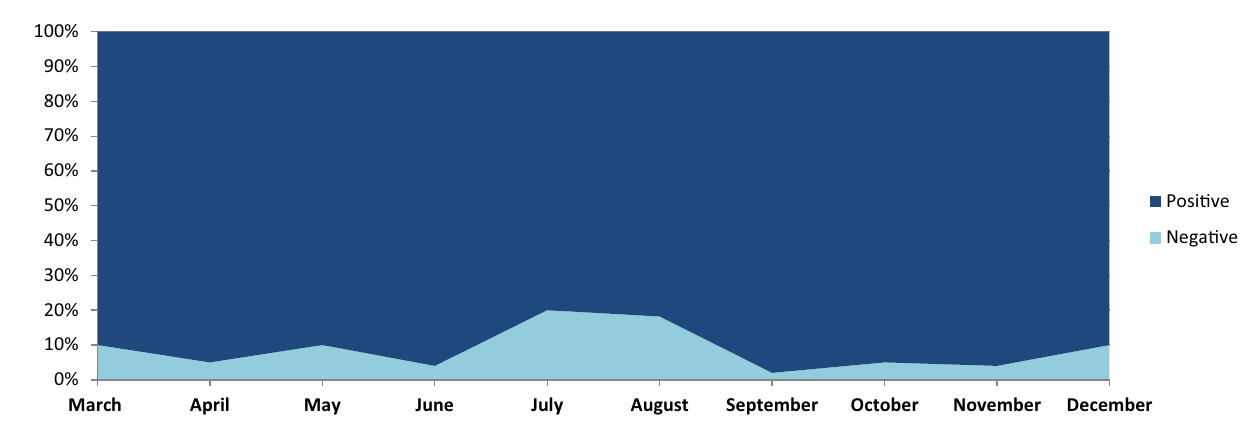
Figure 6. Public opinion analysis on vaccination discussed during the pandemic